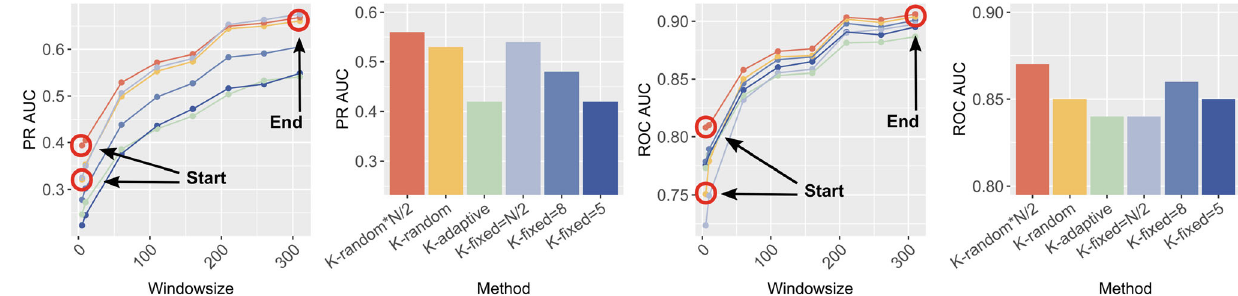
Fig. 3 Comparison of different K strategies with respect to different window size